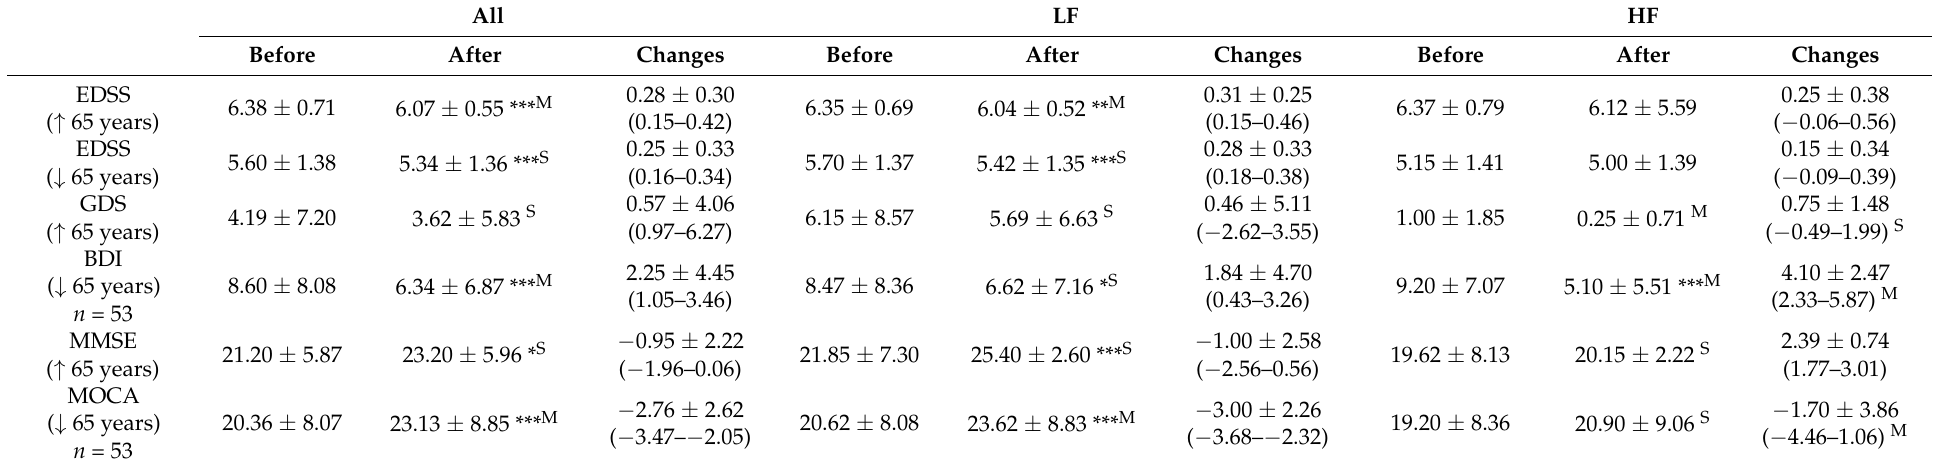
letters L, M, and S indicate large, moderate, and small effect sizes, respectively. ↑ : the group of MS patients over 65 years. ↓ : the group of patients with age below 65